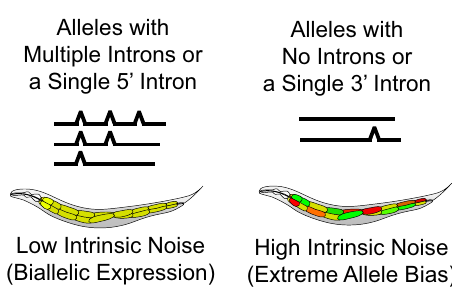
Fig. 8 Summary of intron effects on stochastic allele bias. Left panel shows intron con fi gurations with lower stochastic allele bias. Right panel shows intron con fi gurations with higher stochastic allele